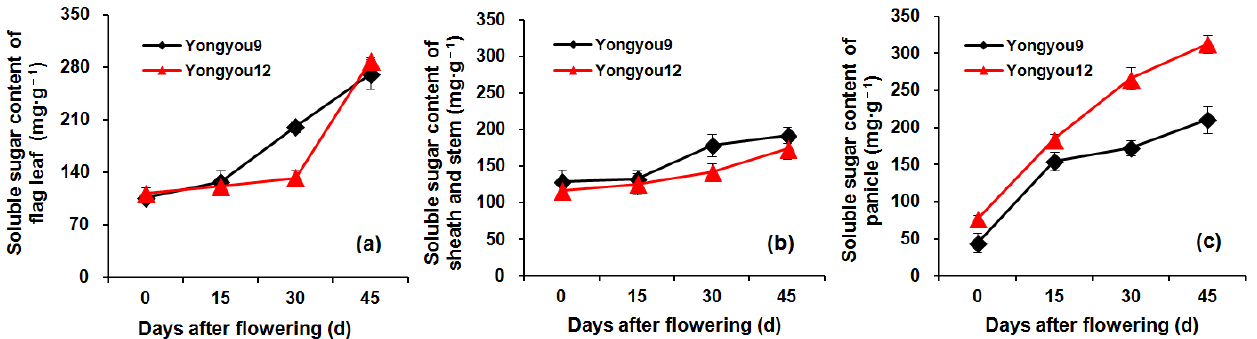
Figure 8. Changes in total soluble sugar content of rice flag leaves ( a ), stems and sheaths ( b ), and panicles ( c ) after flowering. Error bars denote ± standard deviation ( n = 3).